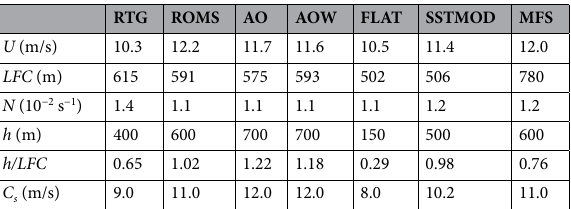
Table 2. Meteorological fields averaged in the rectangular box 45°–45.5°N and 12.5°–13°E evaluated at 09 UTC of 26 September 2007, during the most intense part of the